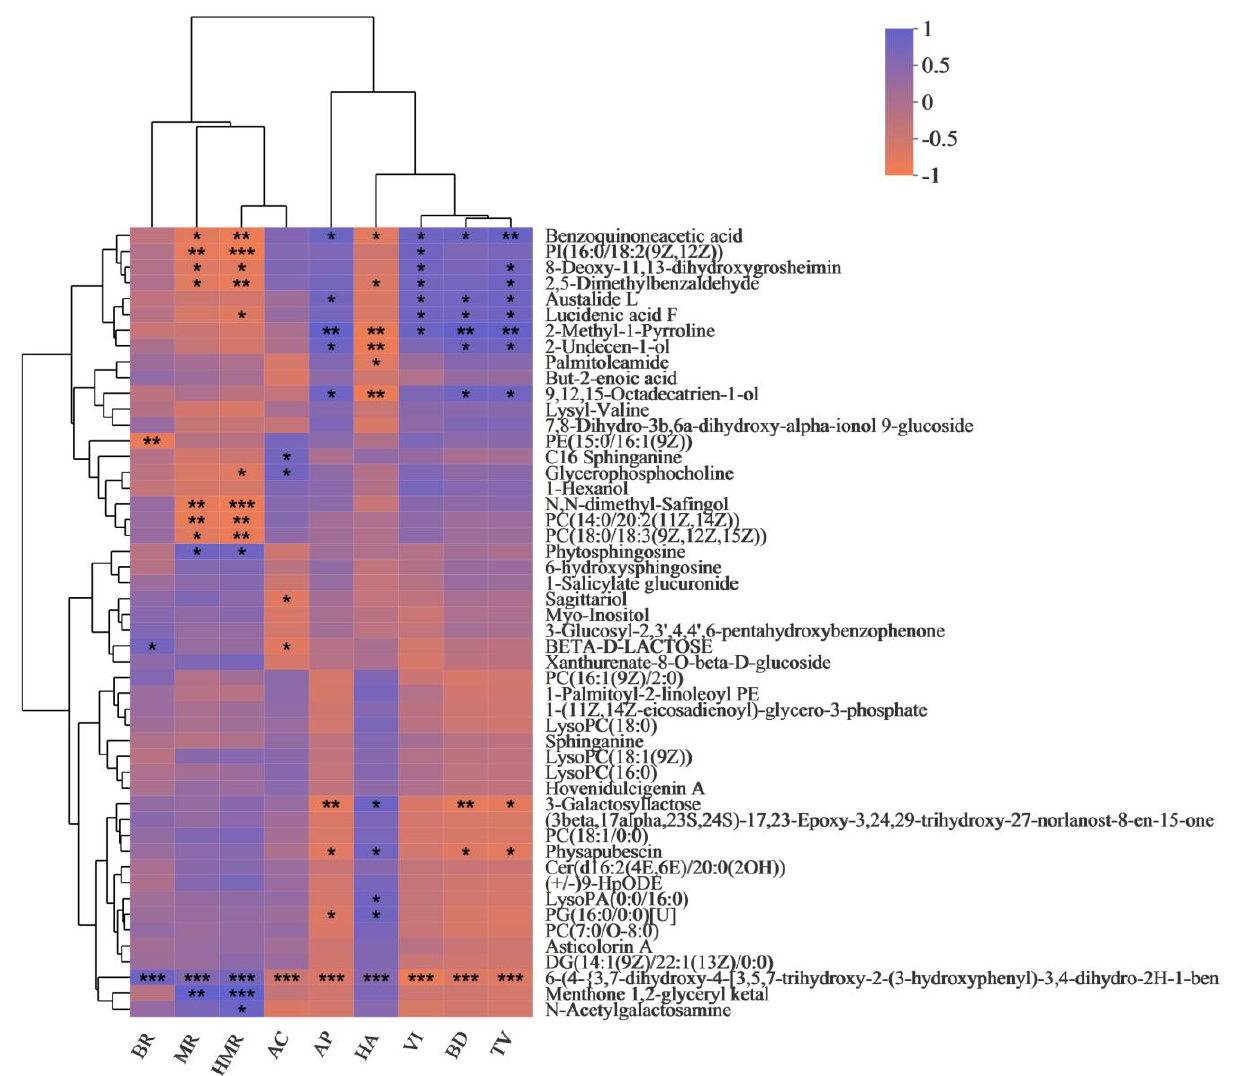
Figure 3. Correlation analysis of BR, MR, HMR, AC, AP, HA, VI, BD, and TV with DMs. The names of the DMs are on the right side, and the names of BR, MR, HMR, AC, AP, HA, VI, BD, and TV are on the bottom. Each grid represents the correlation between the two attributes, and different colors represent the size of the correlation coefficient between the attributes. * p < 0.05; ** p < 0.01; *** p < 0.001.